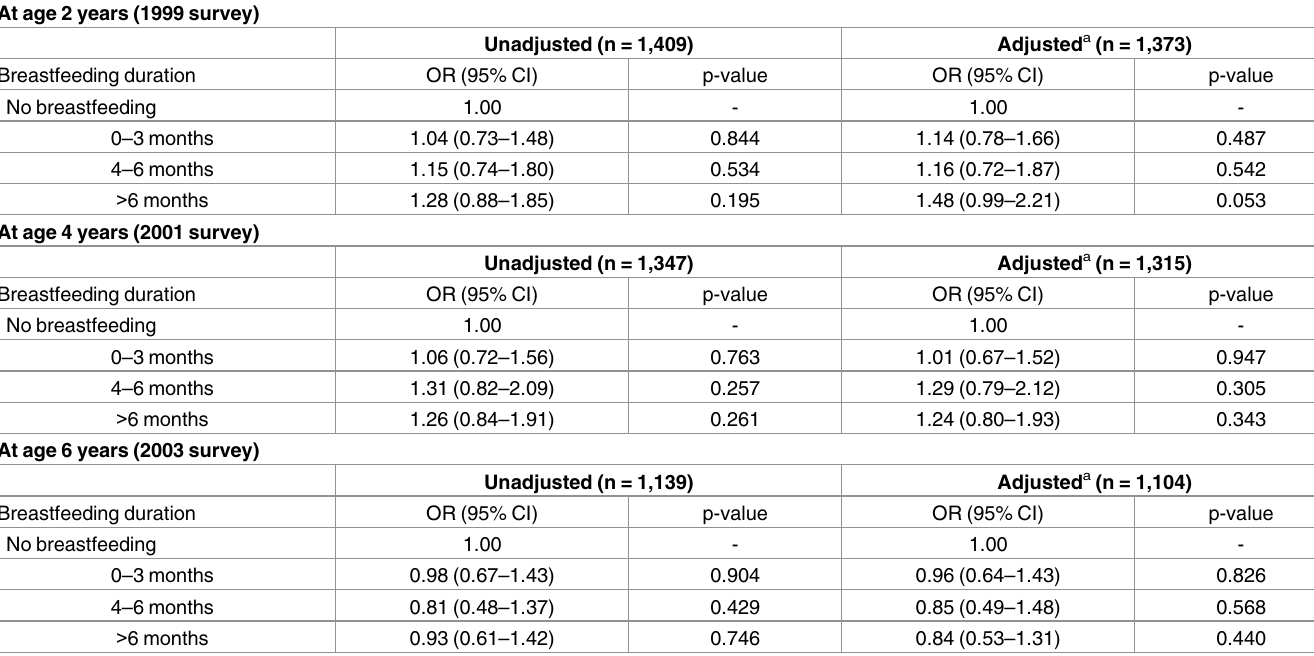
Table 3. Associations between breastfeeding duration and incident eczemaat the ages 2, 4, and 6 years. At age 2 years (1999